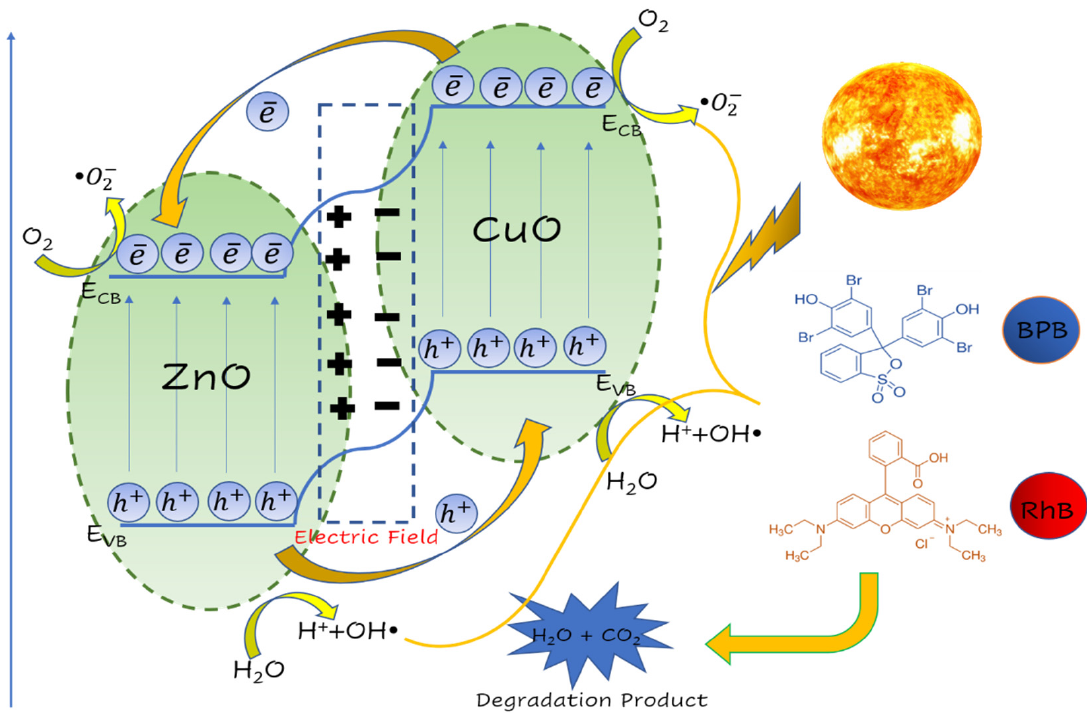
Figure 9. Schematic representation of the photocatalytic degradation of BPB and RhB over the ZnO/CuO nanocomposite.